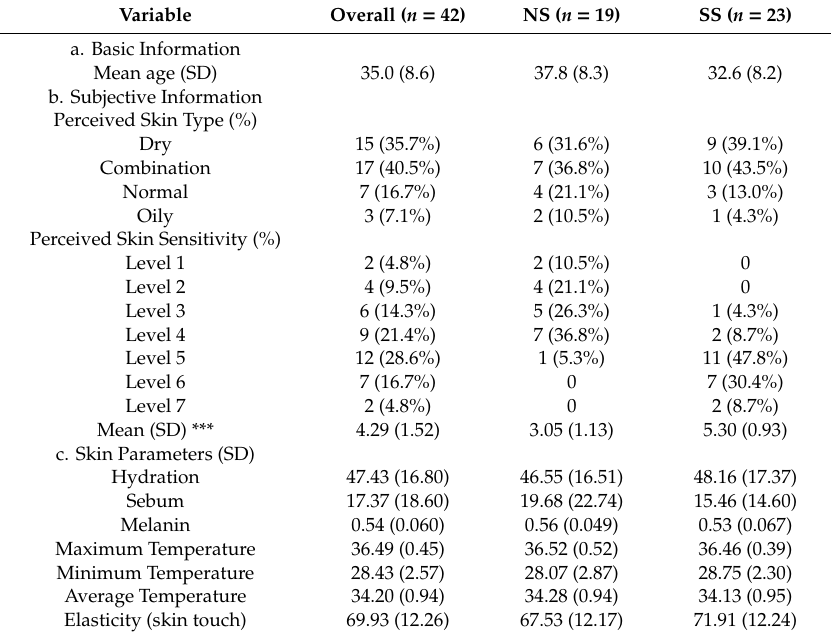
Table 1. The skin characteristics of the subjects.